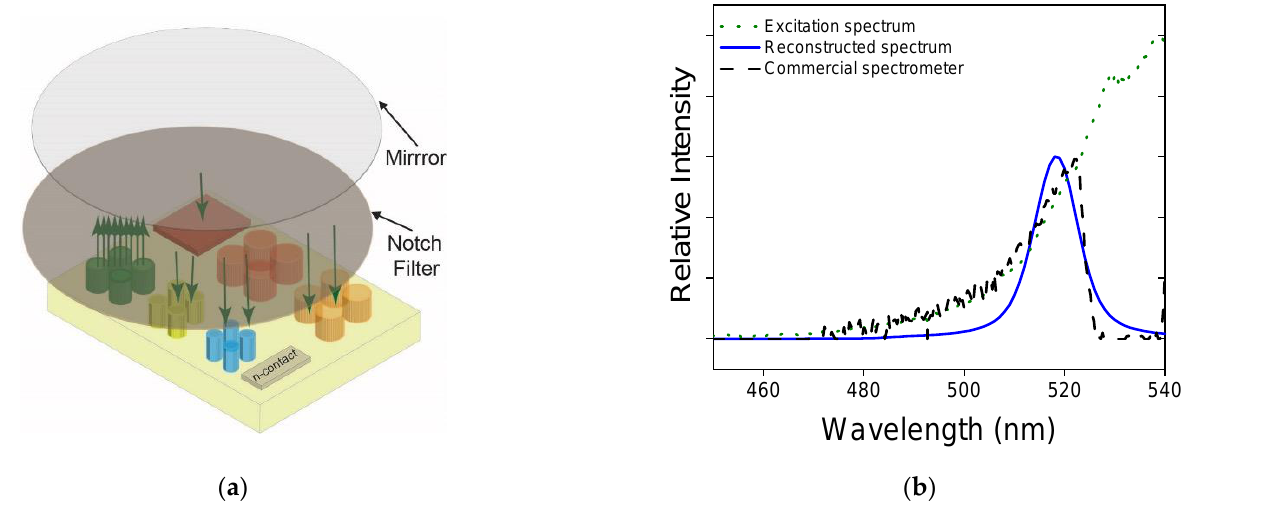
Figure 4. ( a ) The experimental configuration to demonstrate the feasibility of the monolithically integrated LED light source in reflection spectroscopy. A notch filter was used to modify the LED emission. Together with the mirror, the reflected spectrum simulated an analyte absorbing around 533 nm with an absorption linewidth of 17 nm. The distance between the mirror and the chip is 4 cm. No other optics other than the two shown were used. ( b ) The LED emission (green dotted curve), the reflected spectrum (black dashed curve) just above the chip captured by Ocean Optics HR2000, and the reconstructed spectrum (blue solid curve) using an OMP-enhanced NNLS